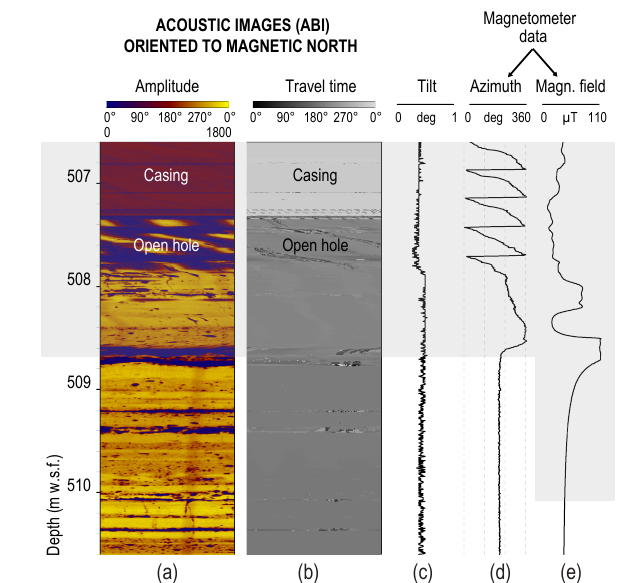
Figure 3. Commonly encountered magnetometer perturbation ob- served when approaching the entrance of a steel pipe or casing as the presence of metal close to the tool perturbs the magnetic field (d, e) . As a result, the acoustic borehole image is incorrectly displayed and oriented (a, b) . Grey shaded area indicates the zone under casing in- fluence, overestimated here (see discussion in Sect. 3.1). mw.s.f. is meter wireline depth below